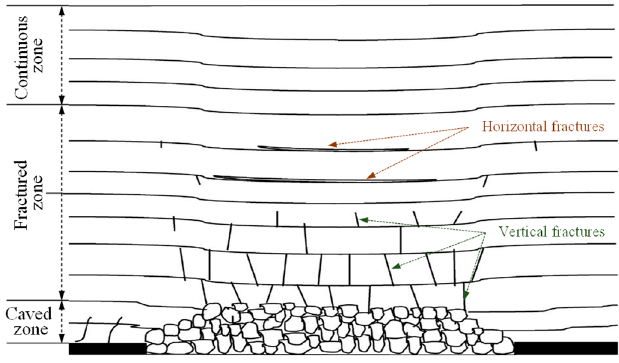
Figure 1. The three-zone